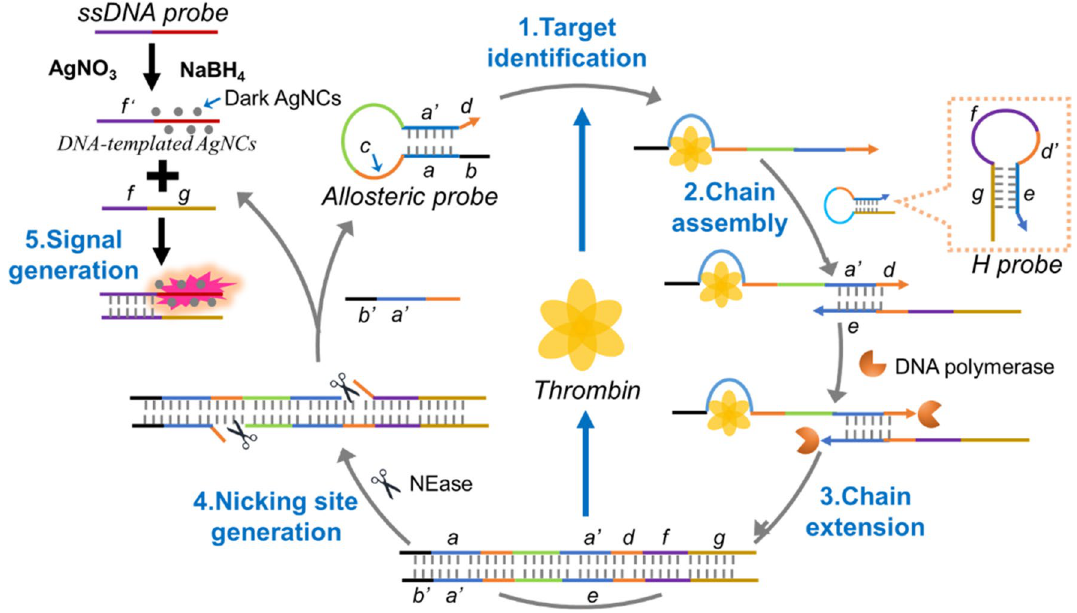
Fig. 1 The working mechanism of the